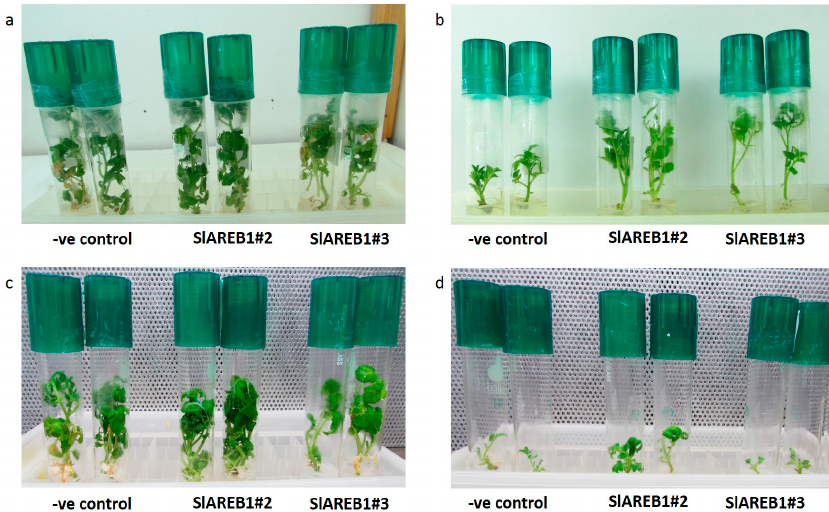
Figure 1. Slow growth preservation of two transgenic lines overexpressing SlAREB1 (SlAREB1#2 and SlAREB1#3) and negative control after 12 weeks of culturing. ( a ) Growth on MS media supplemented with 100 mm sucrose without ABA; ( b ) Growth on MS media supplemented with 200 mm sucrose without ABA; ( c ) Growth on MS media supplemented with 100 mm sucrose and 4 µ m ABA; ( d ) Growth on MS media supplemented with 100 mm sucrose and 8 µ m ABA.